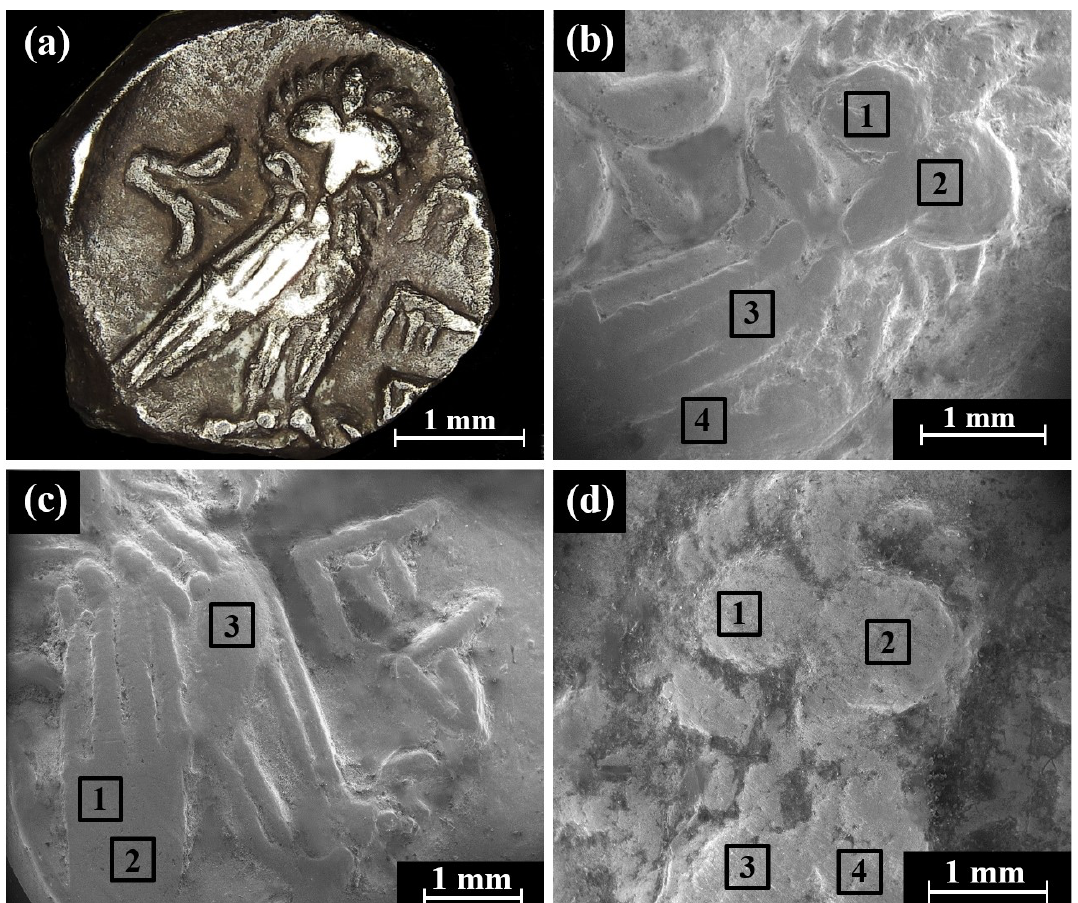
Figure 8. Images of the Yehud gerah Type 5 O1/R4, the reverse of the Ramallah area hoard coins (RH): ( a ) general view of coin RH2 (multi-focal LM); ( b ) RH2 (SEM, SE mode); ( c ) RH3 (SEM, SE mode); and ( d ) RH5 (SEM, SE mode). The areas 1–4 inside the squares were examined by SEM-EDS